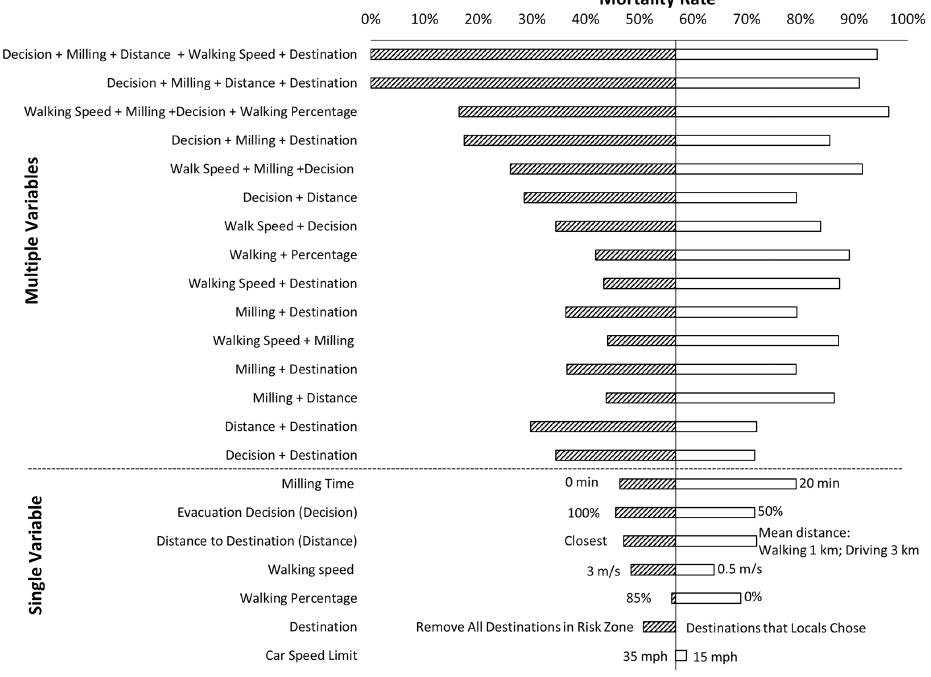
Figure 8. Impact range of model variables.